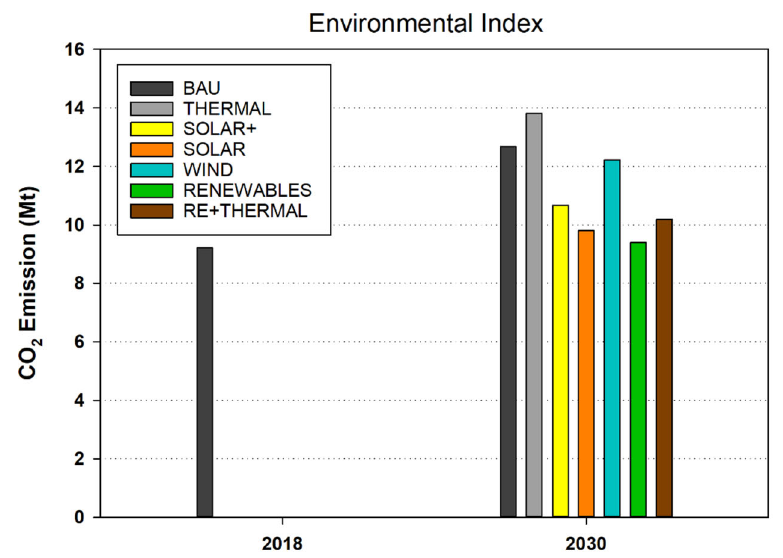
Figure 10. CO 2 emission as environmental index for base and forecast years.